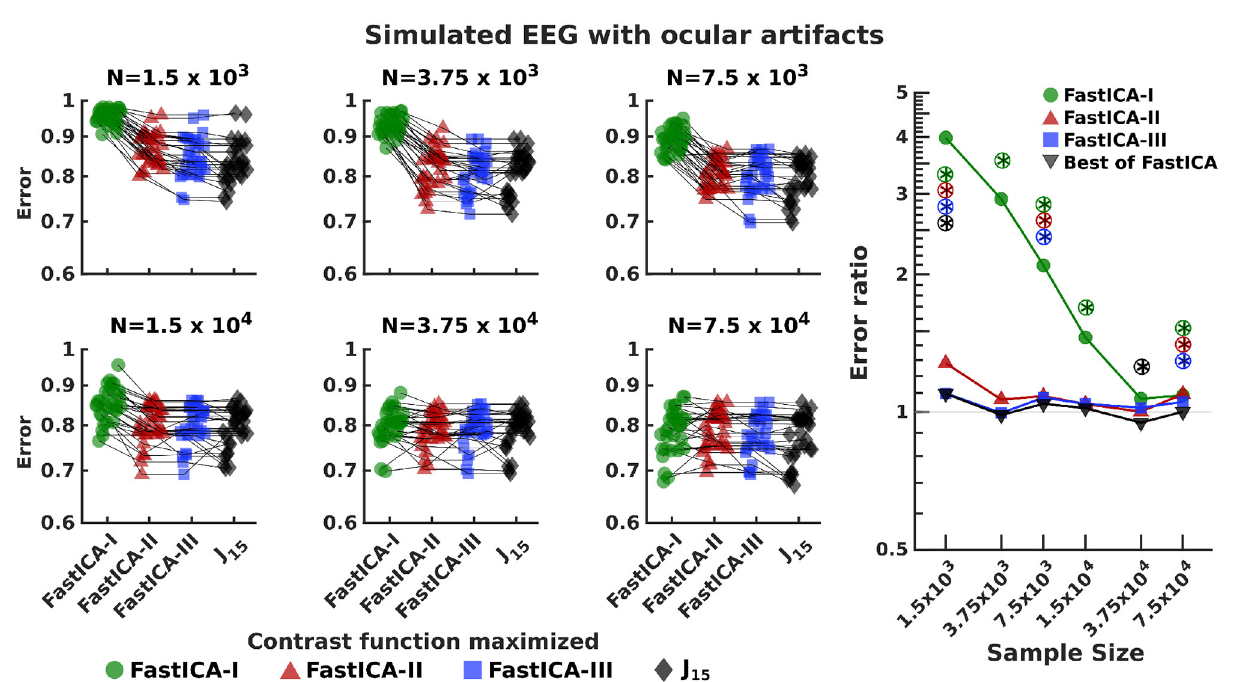
FIGURE6 Comparison of performance of J 15 to that of contrast functions of FastICA for simulated EEG datasets with ocular artifacts. The left 6 panels report the results for 30 EEG datasets generated using simBCI (Lindgren et al., 2018) at 250 Hz, analyzed for run lengths ranging from 6 s (1.5 to 5 min (7.5 10 4 samples). Similar results were found for signals corresponding to both eyes; the average is reported. The right-most panel × compares the error achieved by J 15 to the three FastICA methods. Colored symbols compare J 15 to each FastICA method individually. Gray symbols J 15 to the best performing FastICA method for each dataset. Error ratios greater than 1 indicate that J 15 has the smaller error. *Indicates significant ( p < 0.05) differences, via a two-tailed paired t -test, with p-values computed separately for each comparison. Circled symbols are also significant at p < 0.05 false-discovery-rate